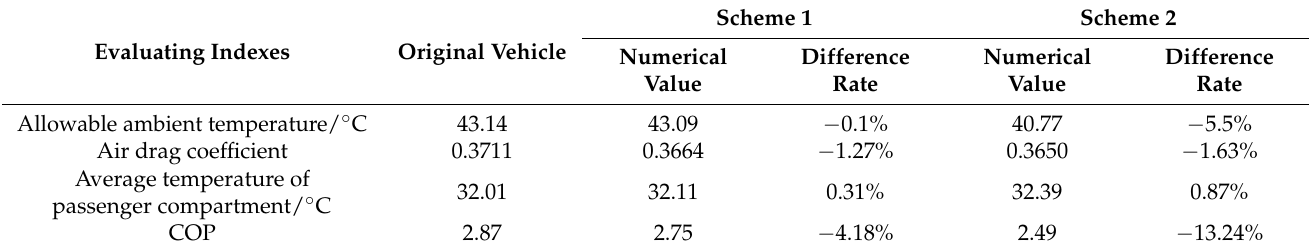
Table 7. Changes of the evaluation indexes under different upper grille schemes.